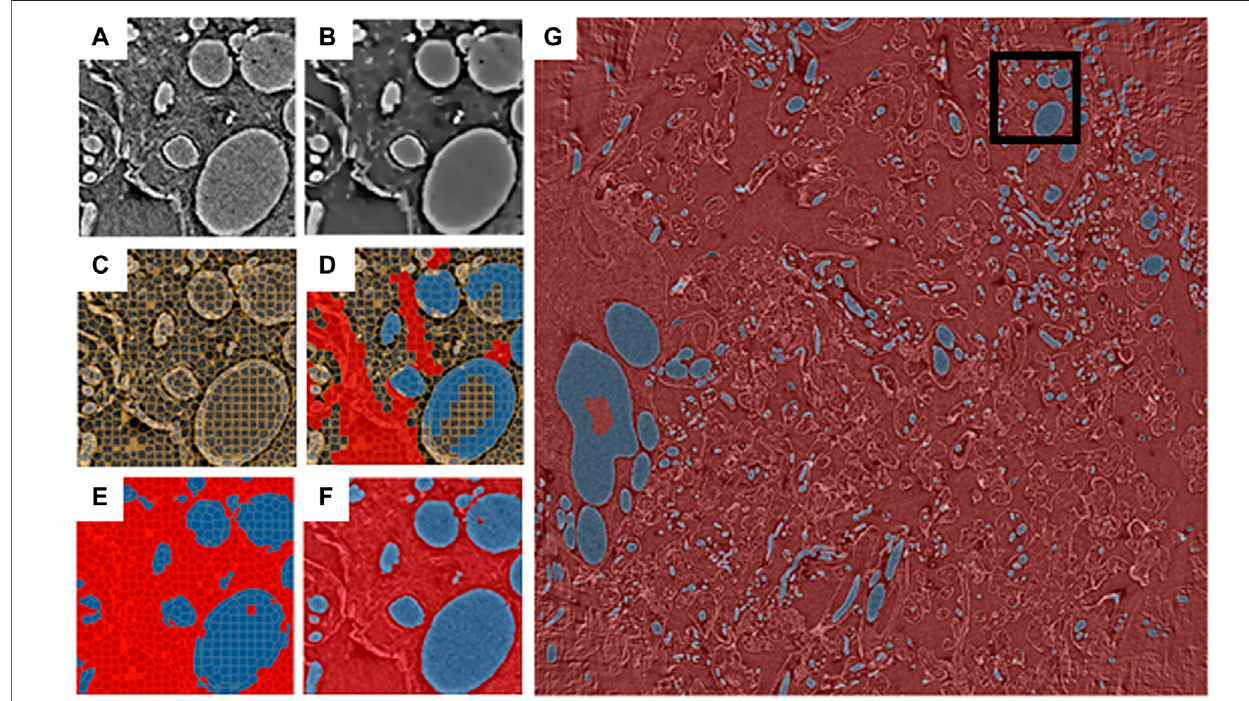
FIGURE2| BloodvesselsfromanX-raymicro-tomographydatasetofhumanplacentasegmentedusingtheSuRVoS2deeplearningpipeline.Images (A – F) show a central slice of a 256 × 256 × 256 pixel region of interest (ROI), marked in (G) with a black box. (A) Raw data. (B) Data with a total variation denoising fi lter applied. (C) Supervoxels generated from the denoised data. (D) Annotations applied to the supervoxels (red: background, blue: blood vessels). (E) Supervoxel-based prediction of segmentation labels using a random forest classi fi er trained on the annotations shown in (D) . (F) Voxel-based prediction of segmentation labels using a 2D U-Net model trained on the segmentation output from (E) and the raw data (A) . (G) Voxel-based predictions of segmentation labels for a central 100 slices of the full 2520 × 2520 dataset using the 2D U-Net model trained as described in (F)